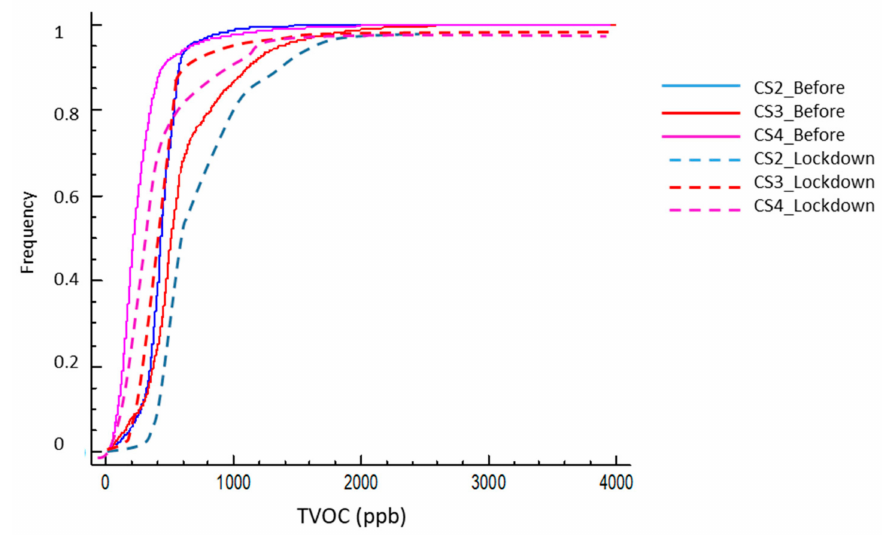
Figure 14. Quantile graph of indoor TVOC concentration before and during the